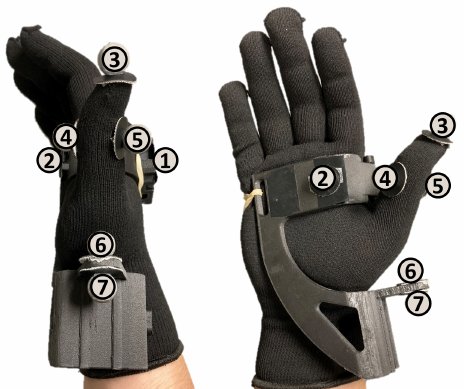
Figure 7. Markers for the thumb trajectory